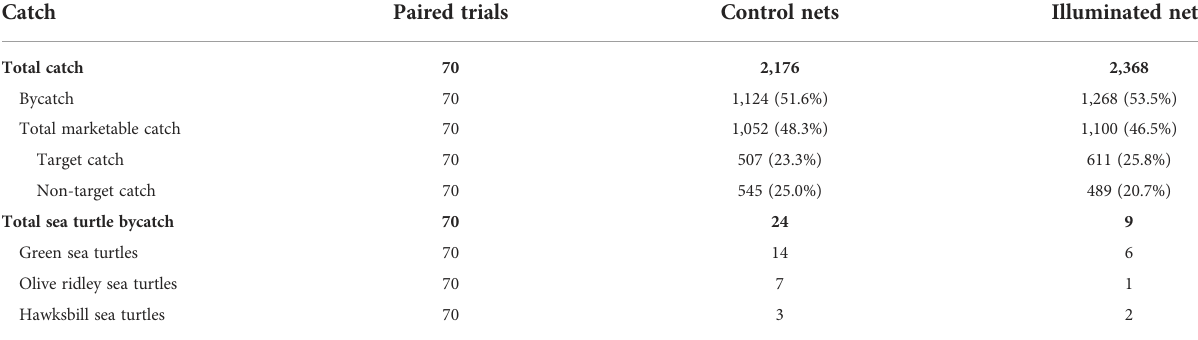
TABLE 2 The amount of total catch, bycatch, total marketable catch, target catch ( Parastromateus niger, Pampus argenteus, and Pampus chinensis ), marketable non-target catch, and sea turtle bycatch for the paired control and illuminated net treatments. Catch